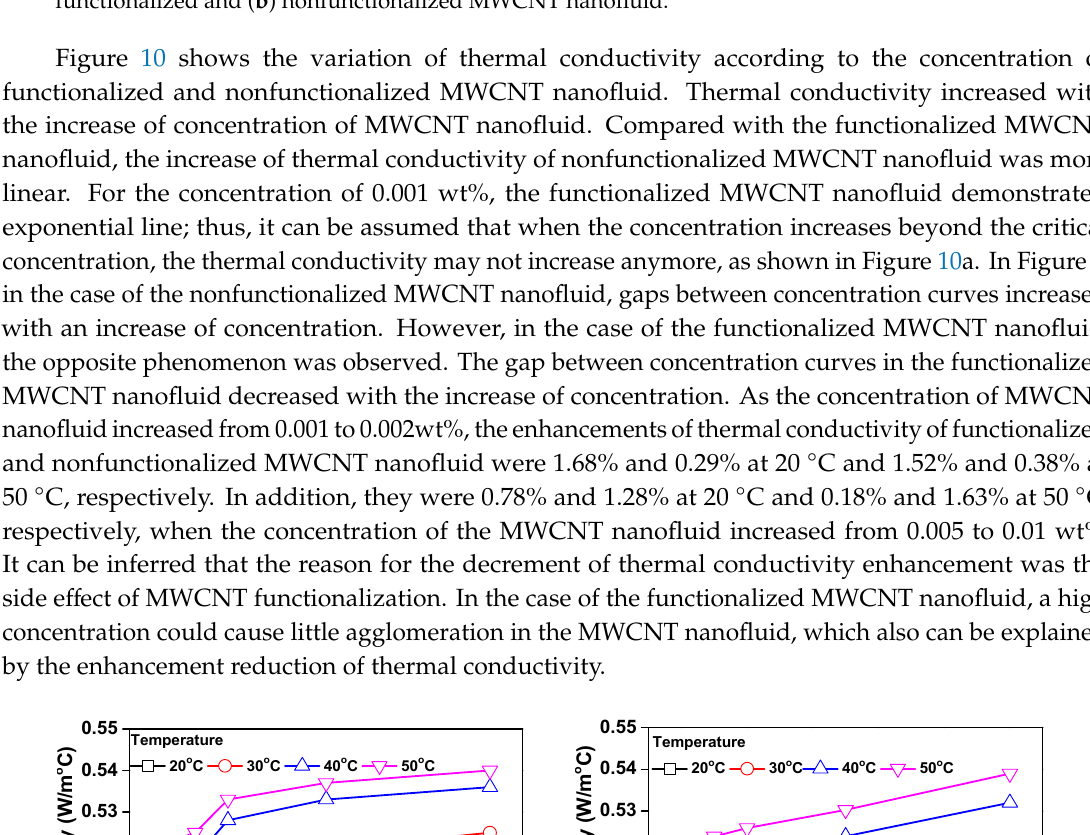
Figure 9. Variation of thermal conductivity with temperature at different weight concentrations of ( a ) functionalized and ( b ) nonfunctionalized MWCNT nanofluid.